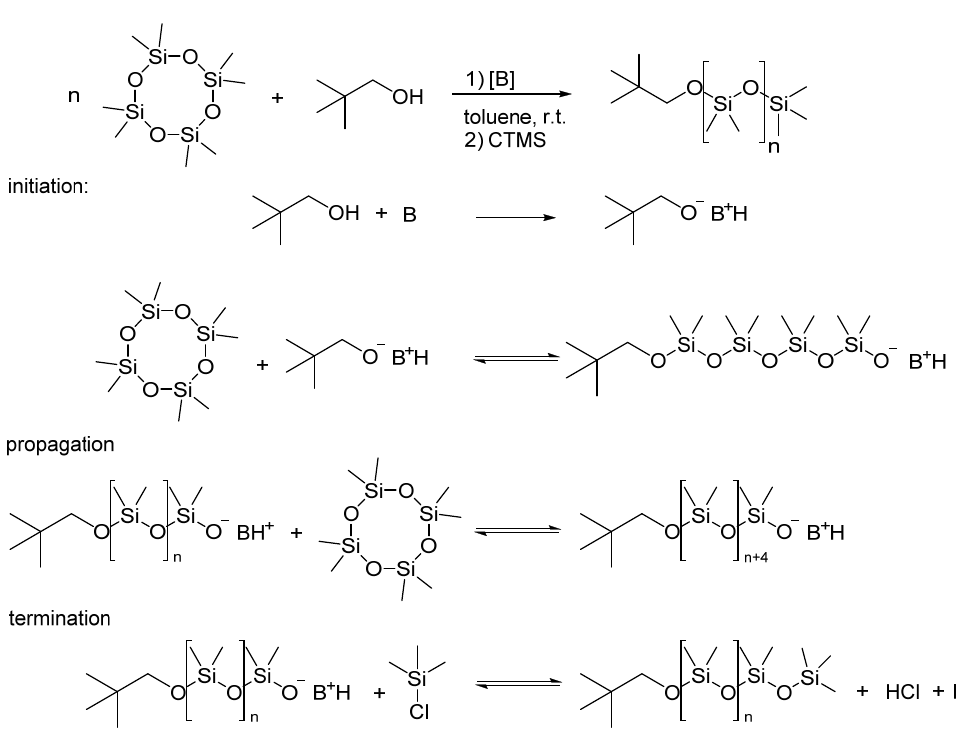
Scheme 1. Mechanism of the ring-opening (ROP) of M 4 initiated by NeOH and phosphazene base.